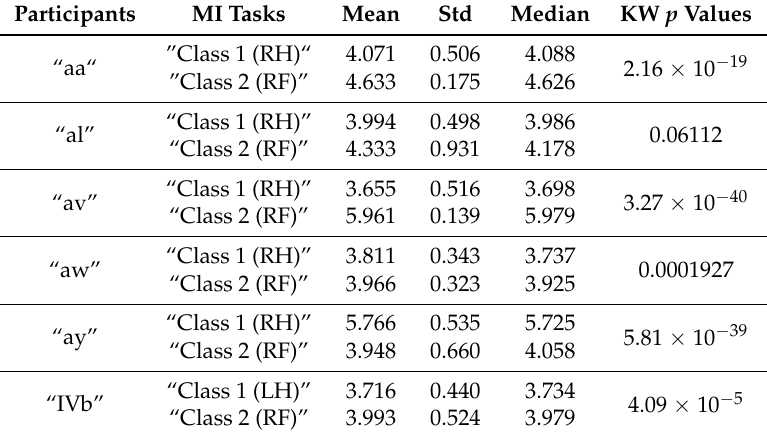
Table 1. Statistical analysis.